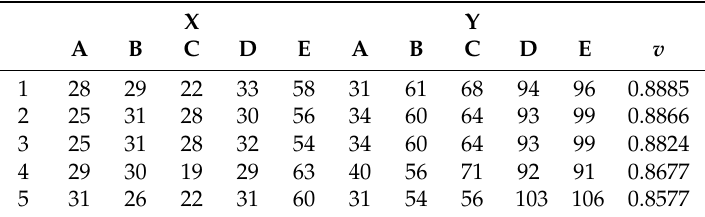
Table 8. Run results.